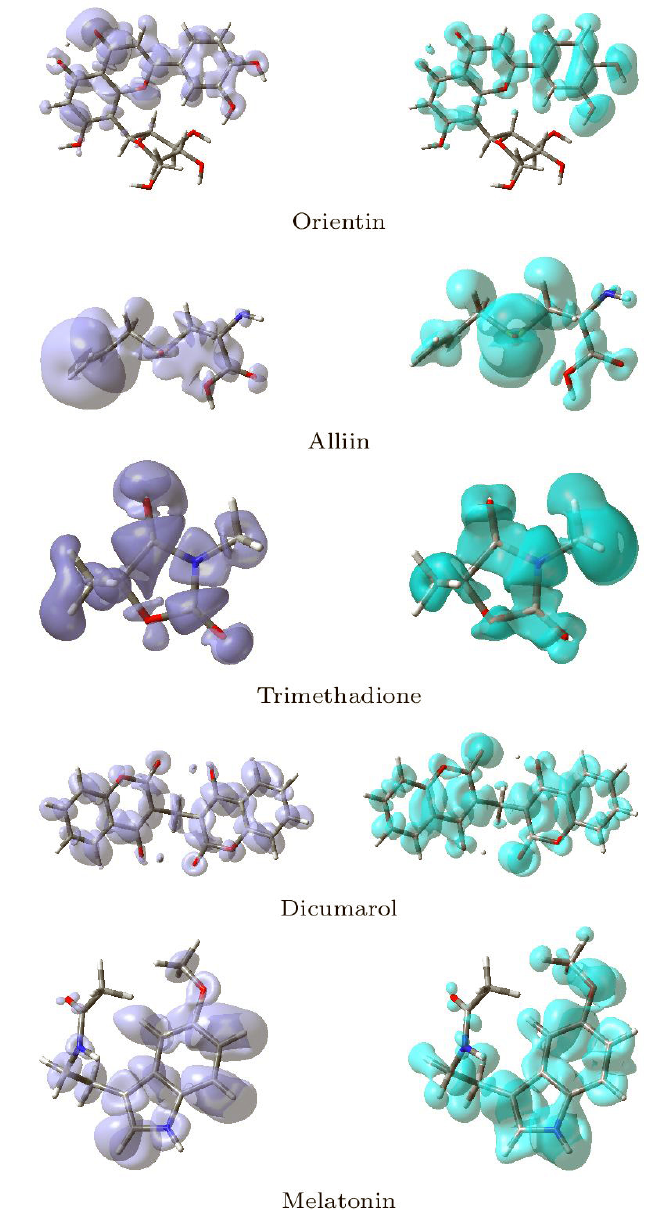
Figure 15. Graphical Representations of the Dual Descriptor DD of the Five Studied Ligands. ( Left ): DD > 0, ( Right ): DD <